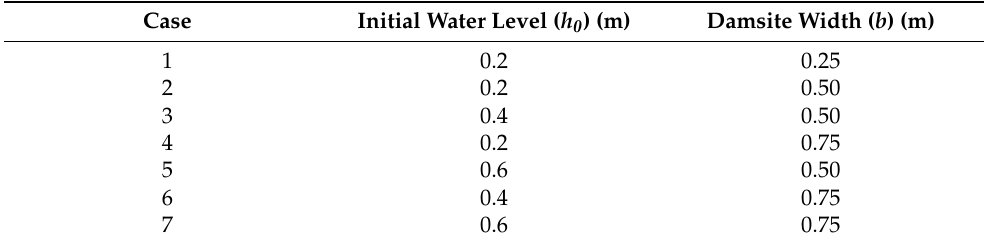
Table 2. Case studies with different value of initial water level in reservoir and the damsite width.